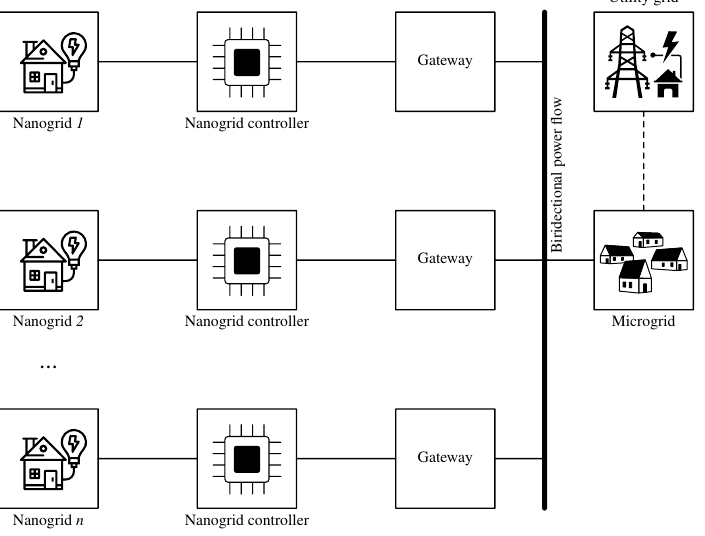
Figure 8. A microgrid consisting of a nanogrid